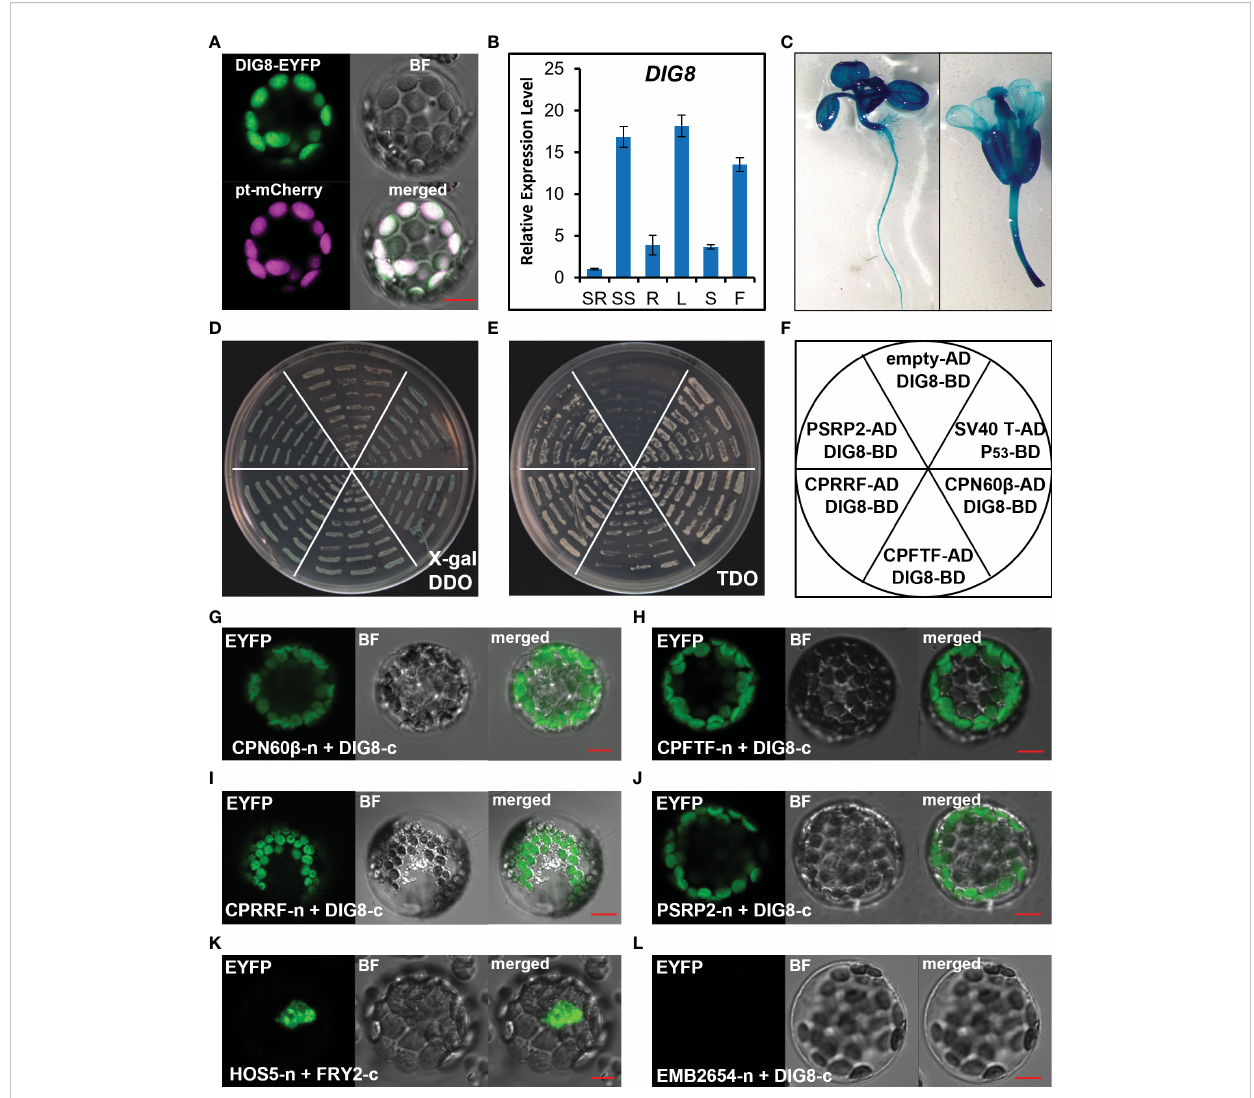
FIGURE 4 Characterization of the DIG8 protein. (A) , DIG8 co-localized with a plastid marker. A DIG8-EYFP construct was co-transformed with plastid-localized marker pt-mCherry in protoplasts. The fl uorescence signals were detected by confocal microscopy. BF, bright fi eld. (B) , qRT-PCR analysis of DIG8 expression. SR, seedling root; SS, seedling shoot; R, root; L, leaf; S, stem; F, fl ower. ACT2 was used as the internal control in qRT-PCR assays. Error bars represent the standard deviations (n=3). (C) , DIG8 promoter-driven GUS expression. Transgenic plants expressing GUS under control of the DIG8 promoter were stained with X-Gluc and imaged under a microscope. (D – F) , Con fi rmation of interactions between DIG8 and predicted DIG8- interacting proteins in the yeast 2-hybrid system. DIG8 was subcloned into the BD vector. CPN60 b , CPFTF, CPRRF, PSRP2 were subcloned into the AD vector. DIG8-BD was co-transformed into yeast with each AD construct. The interactions were expressed on DDO medium with X-gal (D) and TDO medium (E) . (F) , Arrangement of yeast strains shown in (D) and (E) . The empty-AD and DIG8-BD pair was used as a negative control, and the SV40T-AD and P53-BD pair was used as a positive control. (G – L) , Con fi rmation of interactions between DIG8 and predicted DIG8-interacting proteins in protoplasts. DIG8 was subcloned into the c-EYFP vector; the others were subcloned into the n-EYFP vector. DIG8-c was co-transformed into protoplasts with each n-YFP construct. The EYFP signals of DIG8-c with CPN60 b -n (G) , CPFTF-n (H) , CPRRF-n (I) , PSRP2-n (J) were observed by confocal microscopy. (K) , Interaction of HOS5-n and FRY2-c was used as the positive control. (L) , Interaction of EMB2654-n and DIG8-c was used the negative control. Scale bars=10